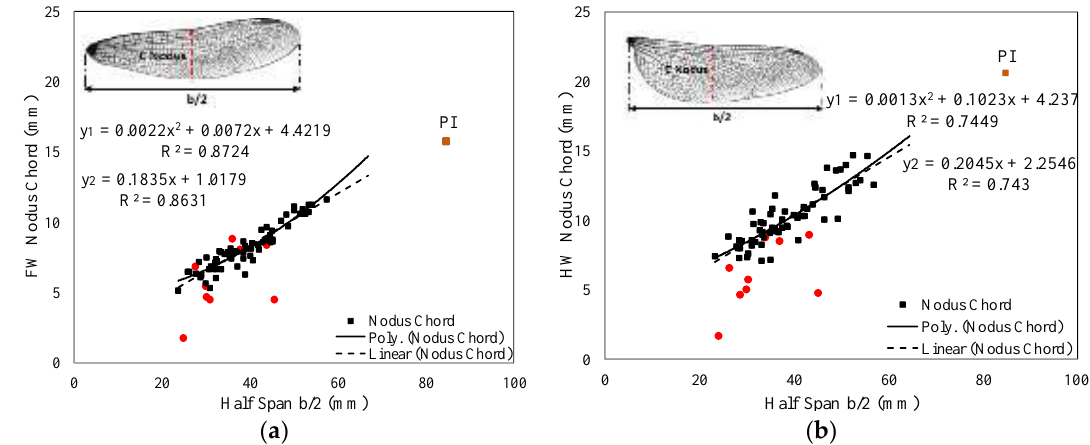
Figure 12. Nodus chord versus wing semi-span of forewings ( a ), and nodus chord versus wing semi-span of hindwings ( b ). Appl. Sci. 2020 , 10 , x FOR PEER REVIEW